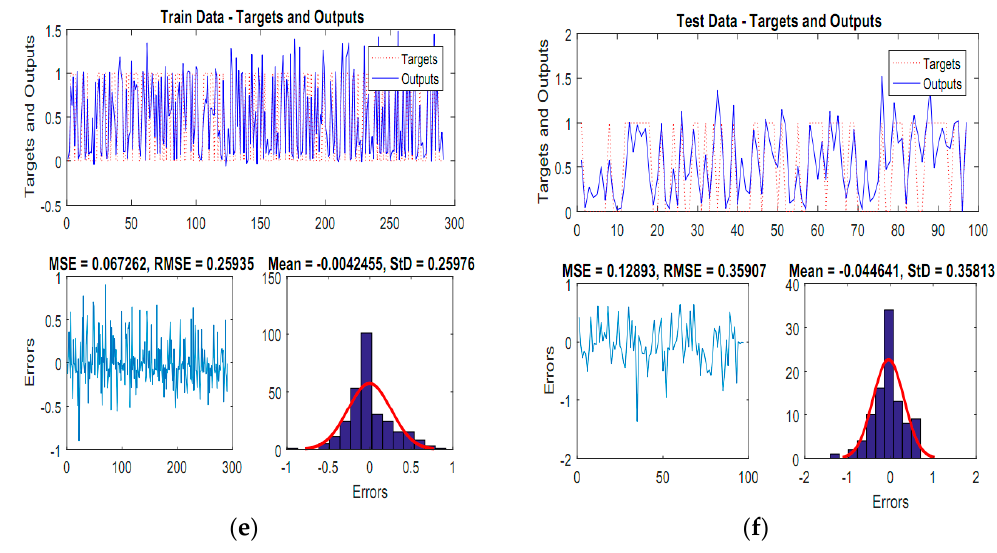
Figure 9. RMSE value of training of ( a ) ANFIS-CA, ( c ) ANFIS-BA, ( e ) ANFIS-IWO and for testing data samples ( b ) ANFIS-CA, ( d ) ANFIS-BA, and ( f ) ANFIS-IWO.